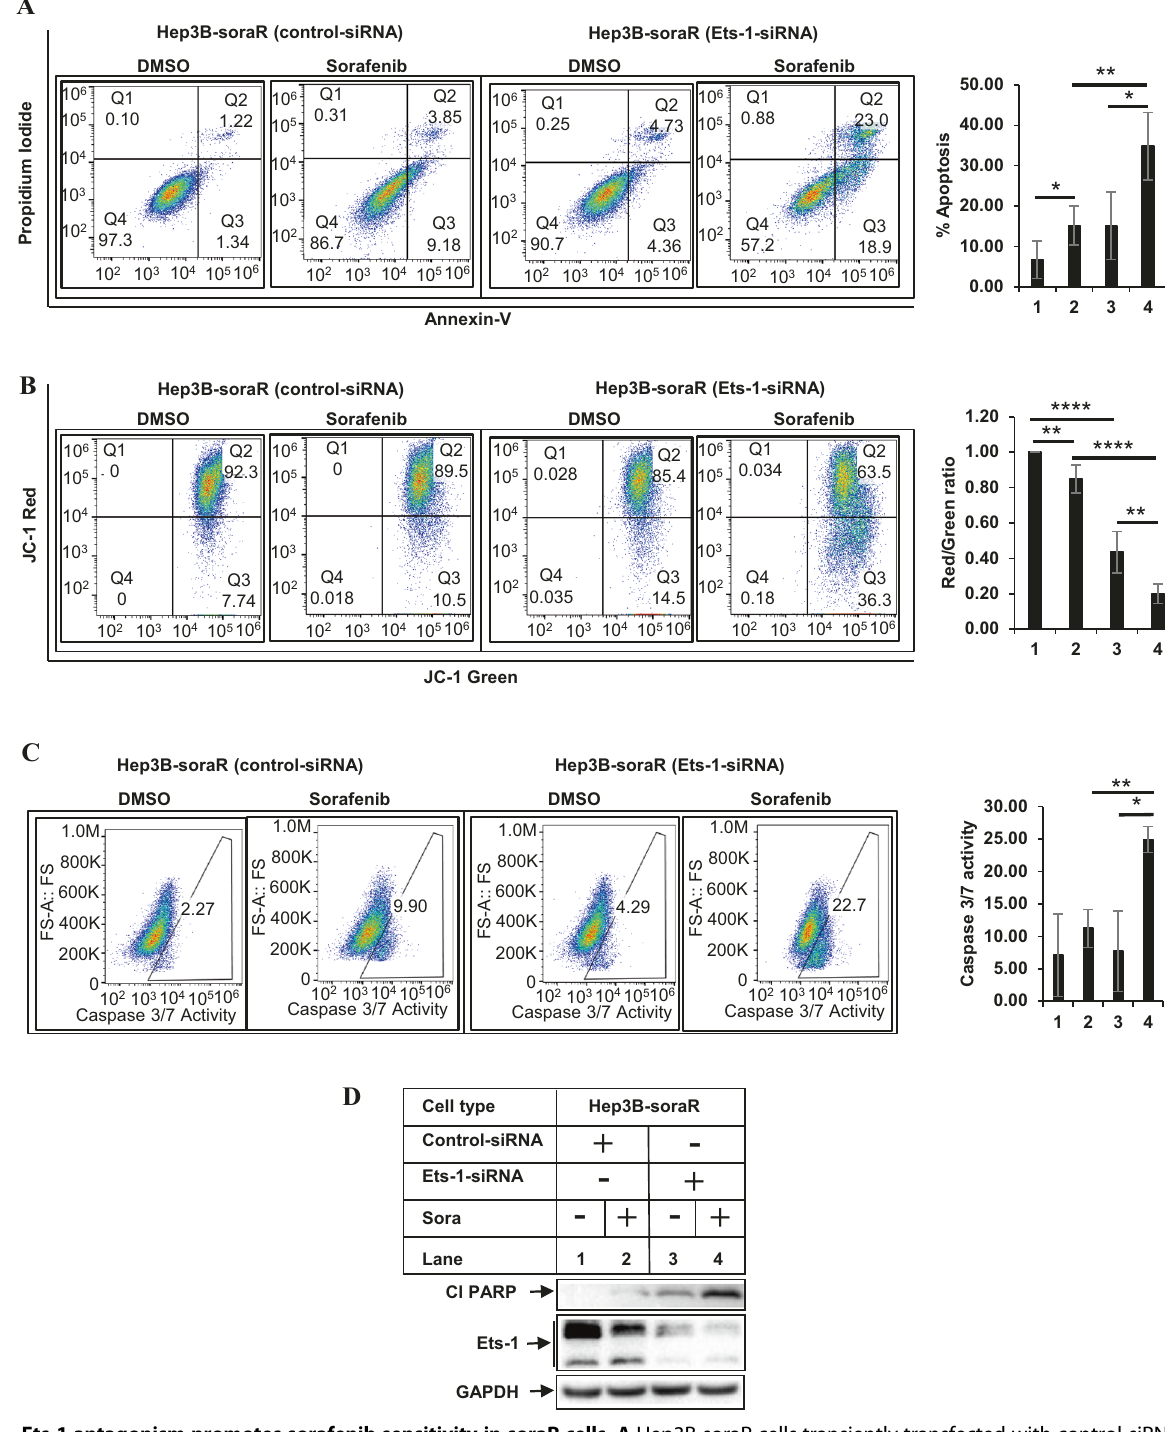
Fig. 6 Ets-1 antagonism promotes sorafenib sensitivity in soraR cells. A Hep3B-soraR cells transiently transfected with control-siRNA or Ets- 1-siRNA were treated with DMSO or sorafenib (6 µM) for 48 h and analyzed by fl ow cytometry to detect apoptosis ( A ), mitochondrial damage ( B ), or caspase 3/7 activity ( C ). The bar graphs on the right of A – C represent the degree of apoptosis, mitochondrial damage, and caspase 3/7 activity respectively. Lanes 1 and 2 were transfected with control-siRNA and lanes 3 and 4 were transfected with Ets-1-siRNA and treated with DMSO (lanes 1, 3) or sorafenib (lanes 2, 4). The data represent the mean ± S.D. of at least three independent experiments. Signi fi cant differences were determined by t test and indicated as: * p ≤ 0.05; ** p ≤ 0.01; **** p ≤ 0.0001. D Hep3B-soraR cells transfected with control- or Ets-1-siRNA were treated with DMSO or sorafenib (6 µM) for 48 h and analyzed by western blots. Cl PARP cleaved PARP.